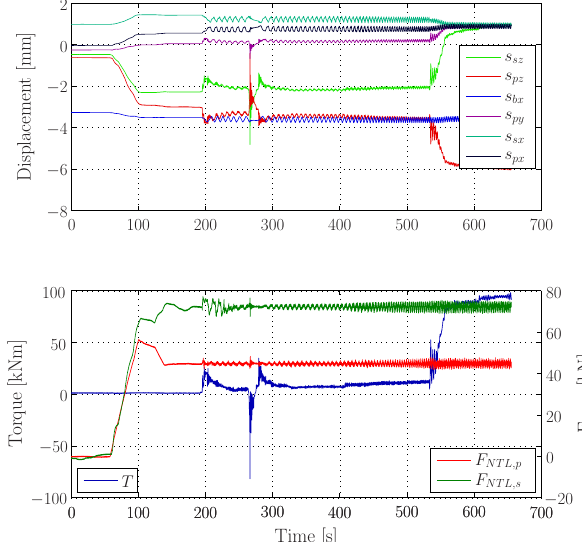
Figure 6: Measured data from the investigated load